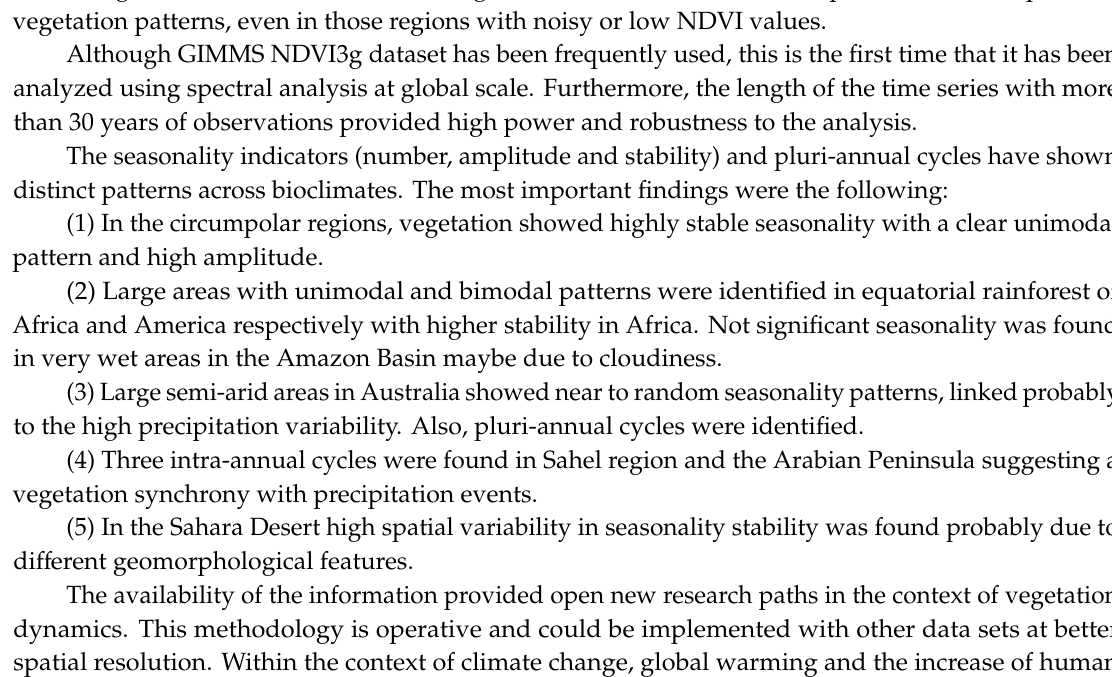
Figure S1: NDVI time series (green) and their periodograms (blue) of di ff erent ecosystems. Locations in Figure S2. Figure S2: The red dots are the locations of selected sites for detailed examination of NDVI time series and periodograms. Figure S3: Spatial distribution of locations with non-significant seasonality (in red). Figure S4: (a) Seasonality mode of NDVI and (b) precipitation time series in the Arabian Peninsula. Figure S5: (a) Seasonality mode of NDVI and (b) precipitation time series in the Sahel area. Table S1: Seasonality indicators derived from periodograms of NDVI time series from the locations of Figure